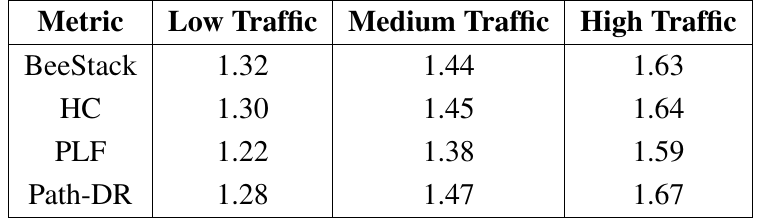
Table 4. Average number of tries that are performed by the MAC layer to transmit one unicast data frame for different metrics and traffic scenarios.